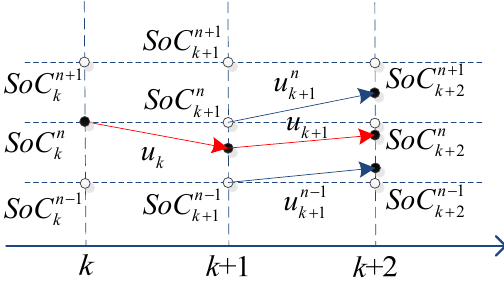
Figure 9. The interpolation diagram during the forward